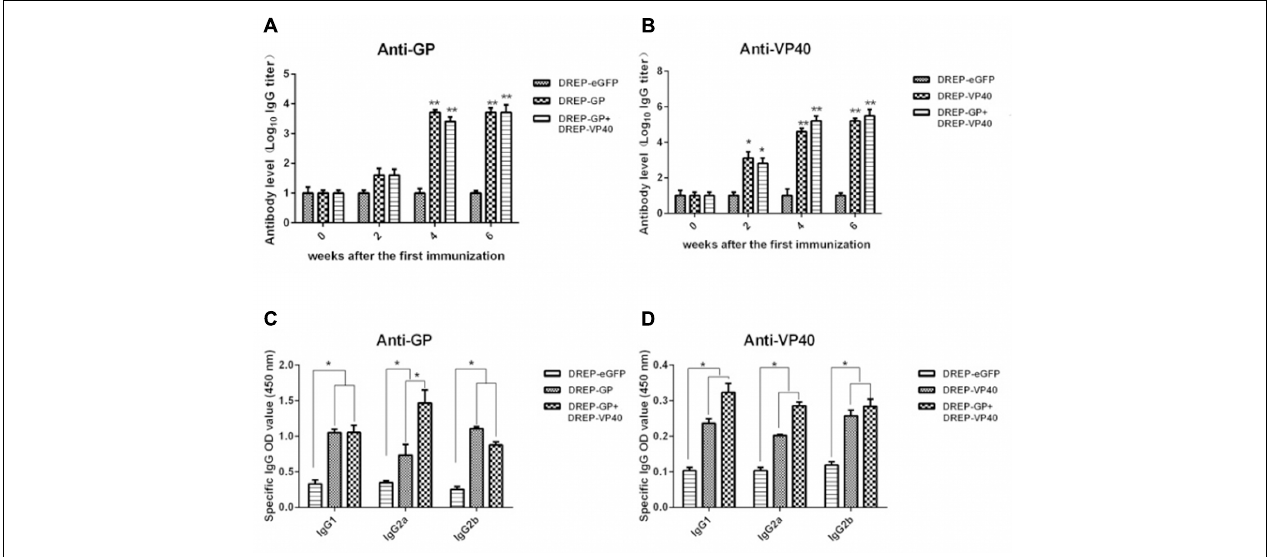
FIGURE 3 | Specific antibody responses induced by immunization with DREP-based GP and VP40 vectors. (A) and (B) Determination of specific anti-GP (A) and anti-VP40 (B) antibodies in the sera of BALB/c mice collected at 0, 2, 4, and 6 weeks after the first immunization. The antibody levels were expressed as the log 10 IgG titers. (C) and (D) IgG subtype analysis of the specific anti-GP (C) and anti-VP40 (D) antibodies derived from the sera of immunized BALB/c mice. Serum samples from mice immunized with DREP-eGFP were used as the negative control. Results were expressed as the mean of OD450 ± SEM. The results presented are representative of three independent experiments. ∗ p < 0.05, ∗∗ p < 0.01.